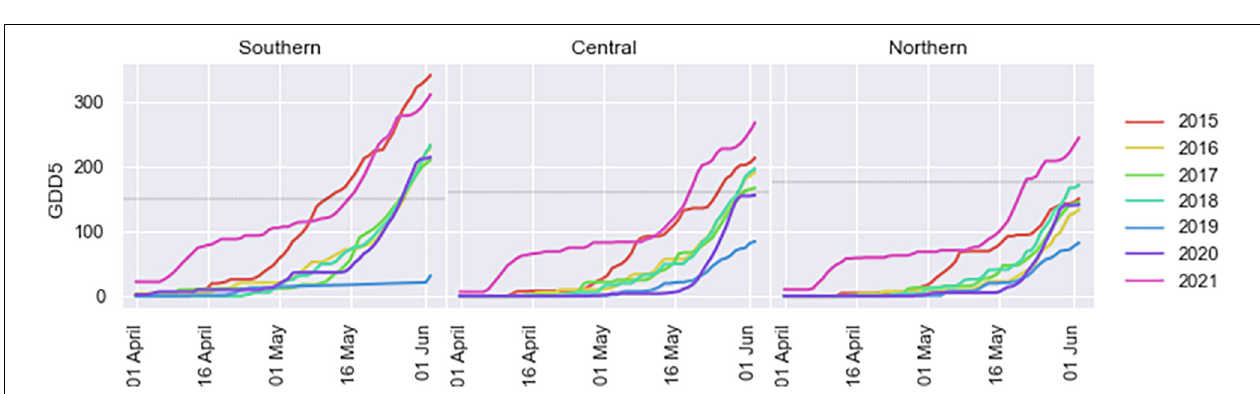
FIGURE 4 | Cumulative growing degree days at 5 ◦ C (GDD5) during spring at each plantation test site during their seven growing seasons. Dashed horizontal line represents the GDD5 corresponding to the predicted average date of bud break date at each test site based on Marquis et al. (2020) for the northern site and Li et al. (1993) for the southern